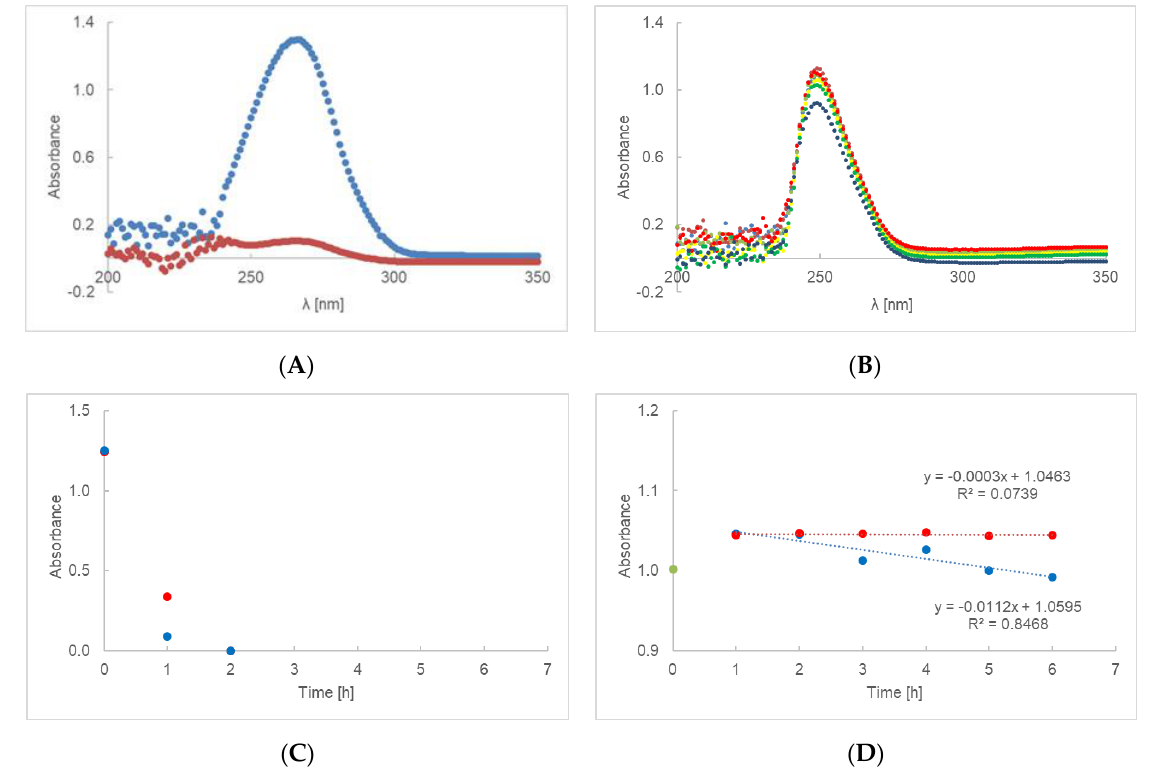
Figure 4. UV-Vis spectra of preparation AA-AV ( A ) and AE-AV ( B ), irradiated at 0( – ), 1( – ),2( – ), 3( – ), 4( – ), 5( – ) and 6( – ) h. The UV degradation gel containing PA and ascorbic acid ( C ), or ethyl ascorbic acid ( D ), presented as time function of absorbance. Red dots represent unexposed samples and blue dots represent irradiated samples. During the first hour, the specimen stabilizes—green dot represents the starting point of the procedure on ( D ) graph.